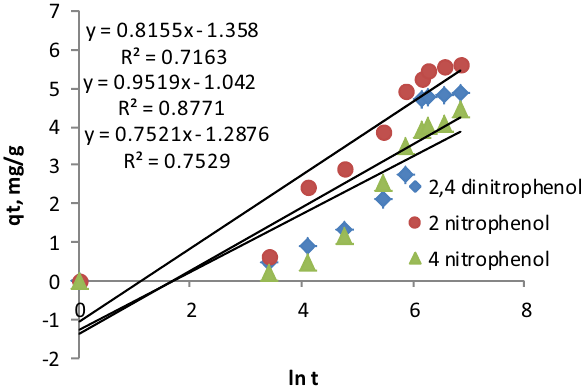
Fig. 11 Elovich model of phenols on char ash